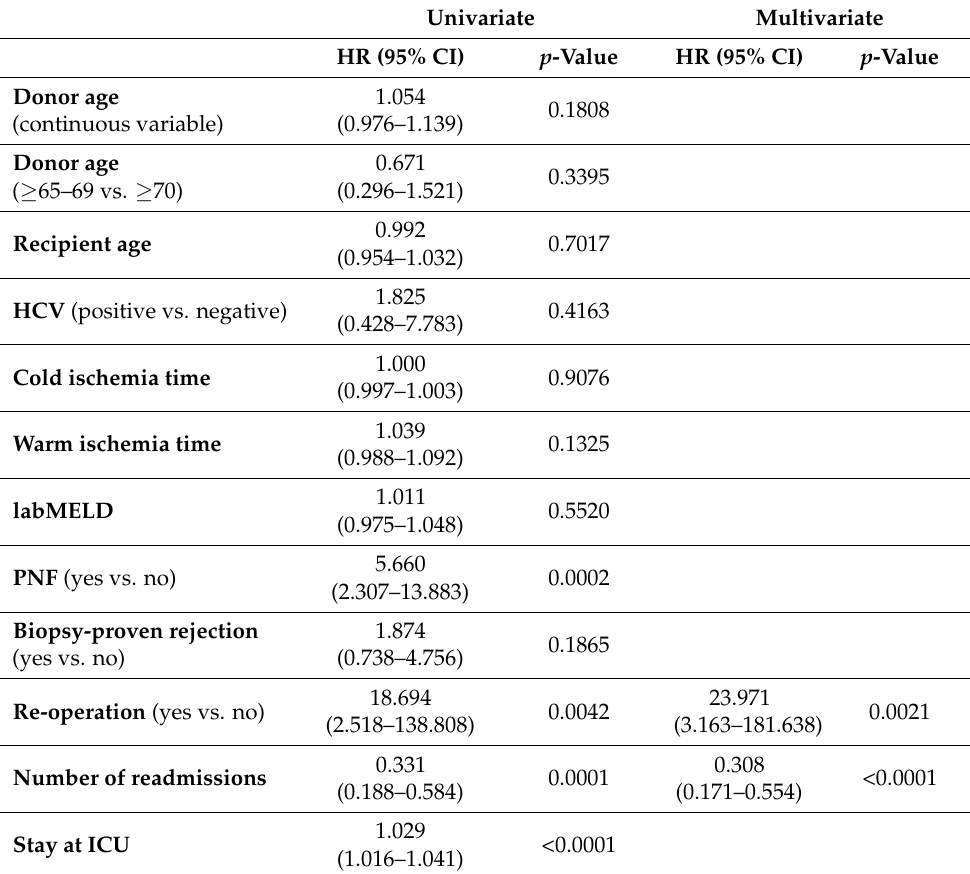
Table 5. Cox proportional hazards regression model with univariate and multivariable Cox regression analyses of one-year patient survival for recipients of grafts ≥ 65 years.